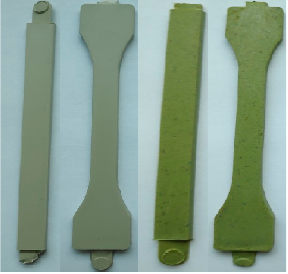
Figure 1. Uniform aspect of the injected